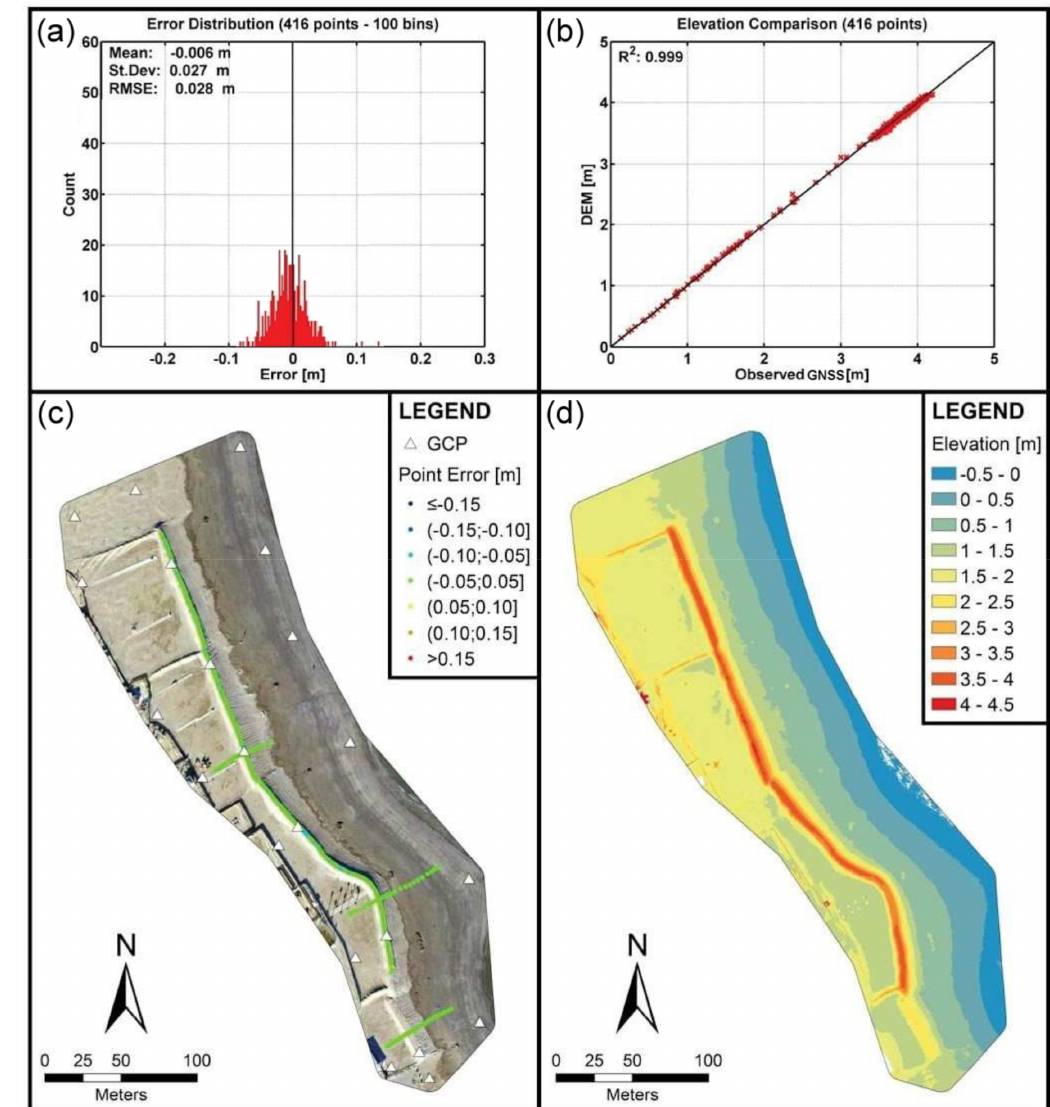
Figure 6. Error analysis for the survey implemented on the 20 January 2017: ( a ) distribution of the errors and synthetic descriptors; ( b ) correlation between the DEM and GNSS measurements; ( c ) orthophoto, spatial distribution and entity of the errors, and position of the GCPs; and ( d ) digital elevation